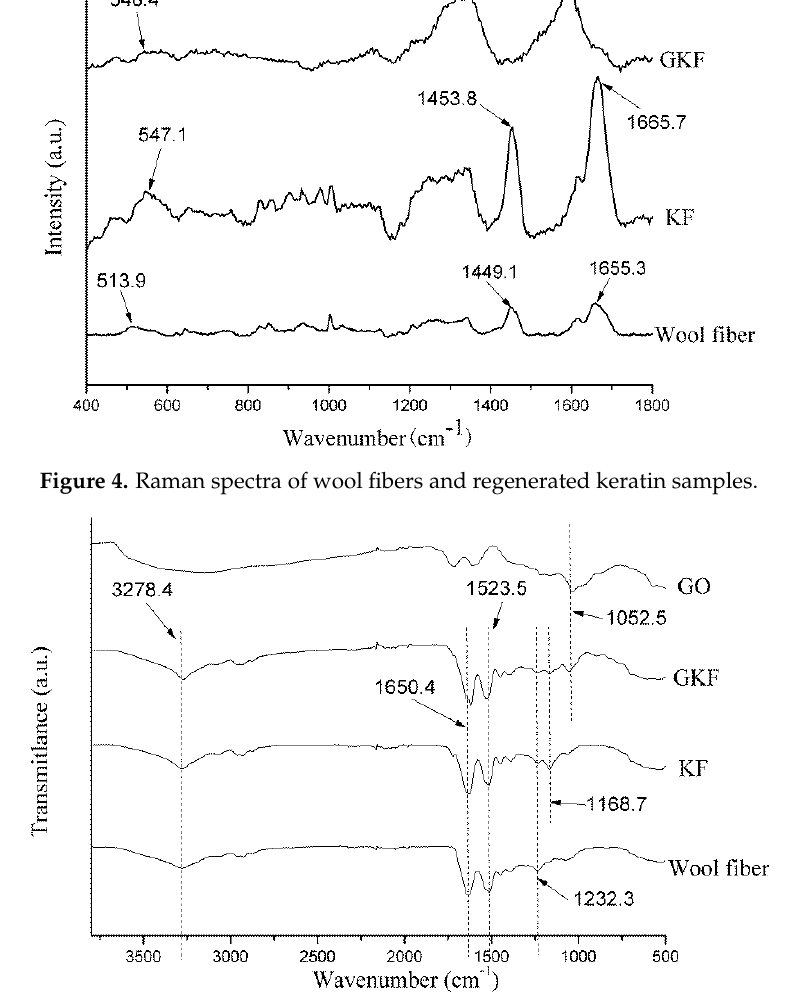
Figure 5. Fourier infrared spectra of wool fibers and regenerated keratin samples.